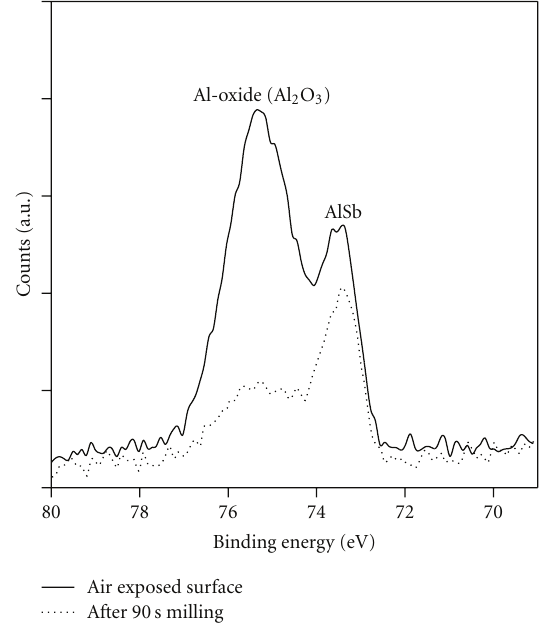
Figure 8: XPS narrow scan of Al(2p) region (a) premilled and (b) 90 second milling surface of Al 0 . 05 Ga 0 . 95 Sb grown at 600 ◦ C with a V/III ratio of